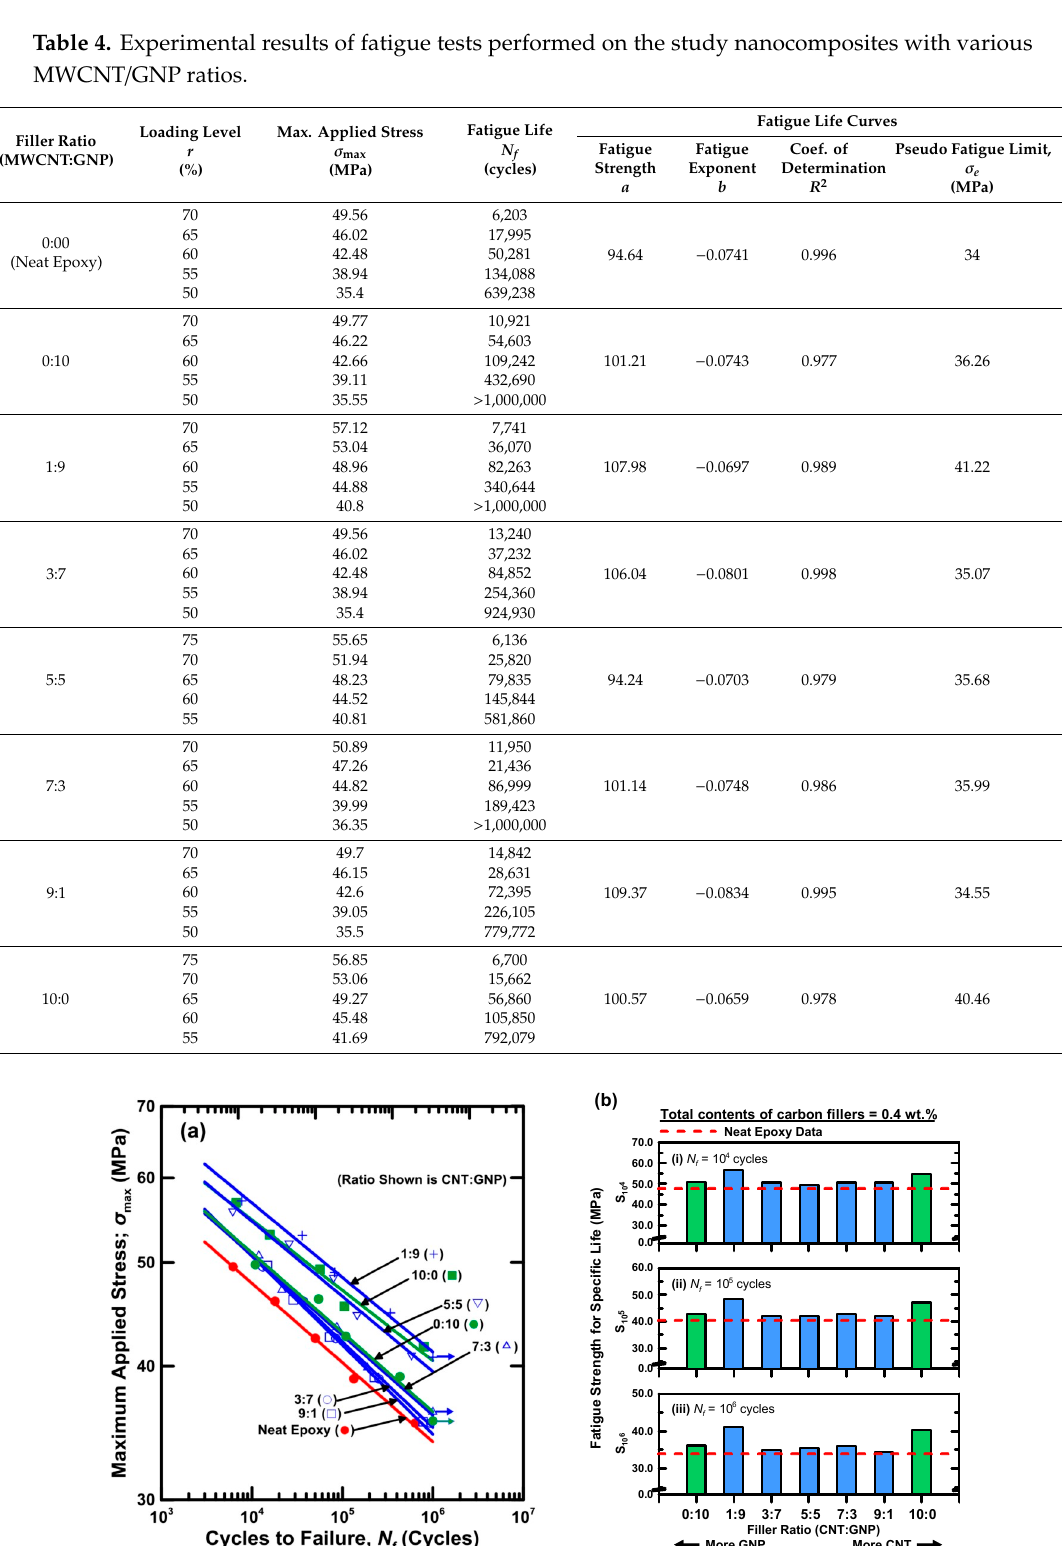
Figure 9. Variation of synergistic indexes χ of the fatigue strengths at 10 4 -, 10 5 -, and 10 6 -cycle lives of the nanocomposites with the employed filler ratios.